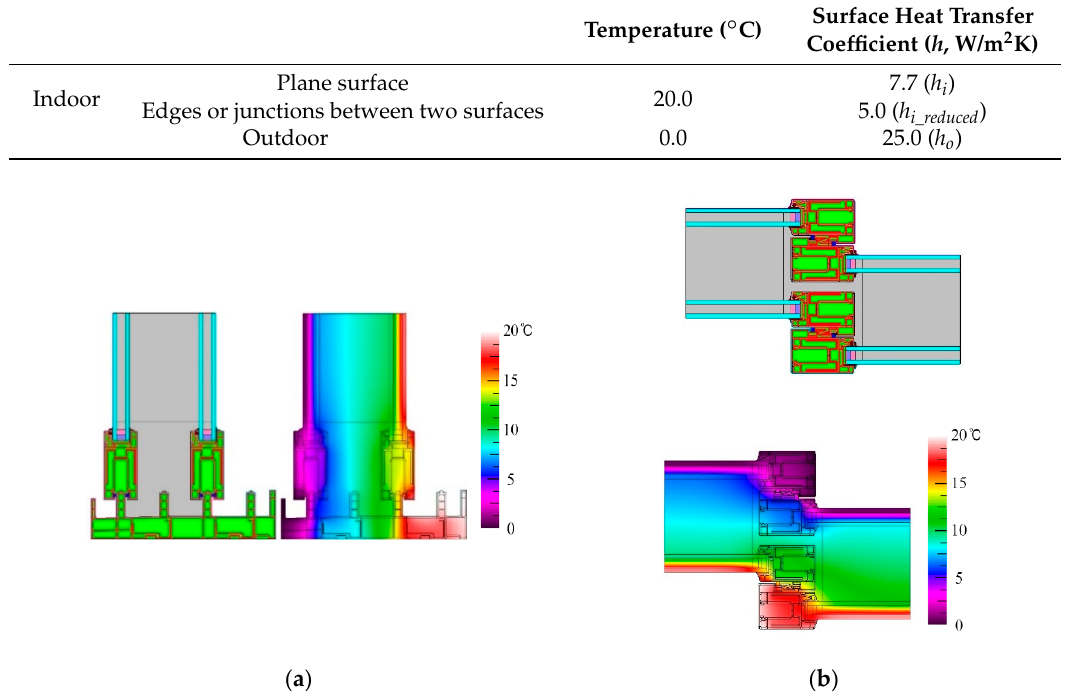
Figure 9. Therm simulation models and results (Case 1-0): ( a ) sill; ( b ) meeting rail.